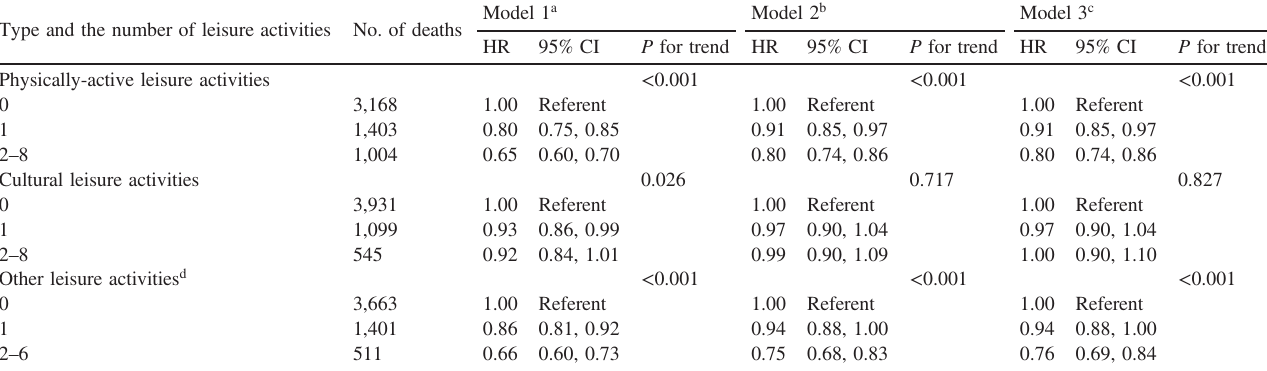
Table 3. Association of the types and the number of leisure activities with all-cause mortality in older Japanese adults ( n = 48,216), Japan, 2010 – 2016 Model 1 Type and the number of leisure activities No. of deaths